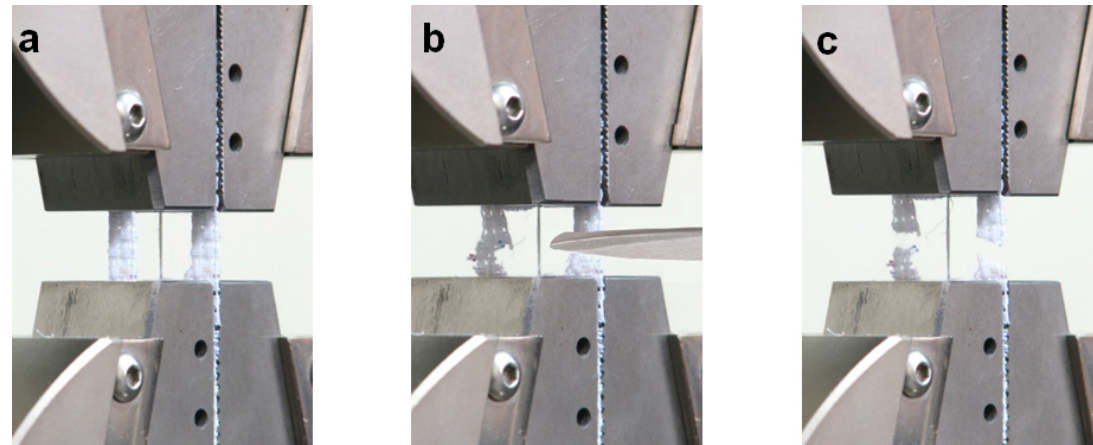
Figure 4- Tensile test: colocation of the sample a); frame cutting procedure b); test development